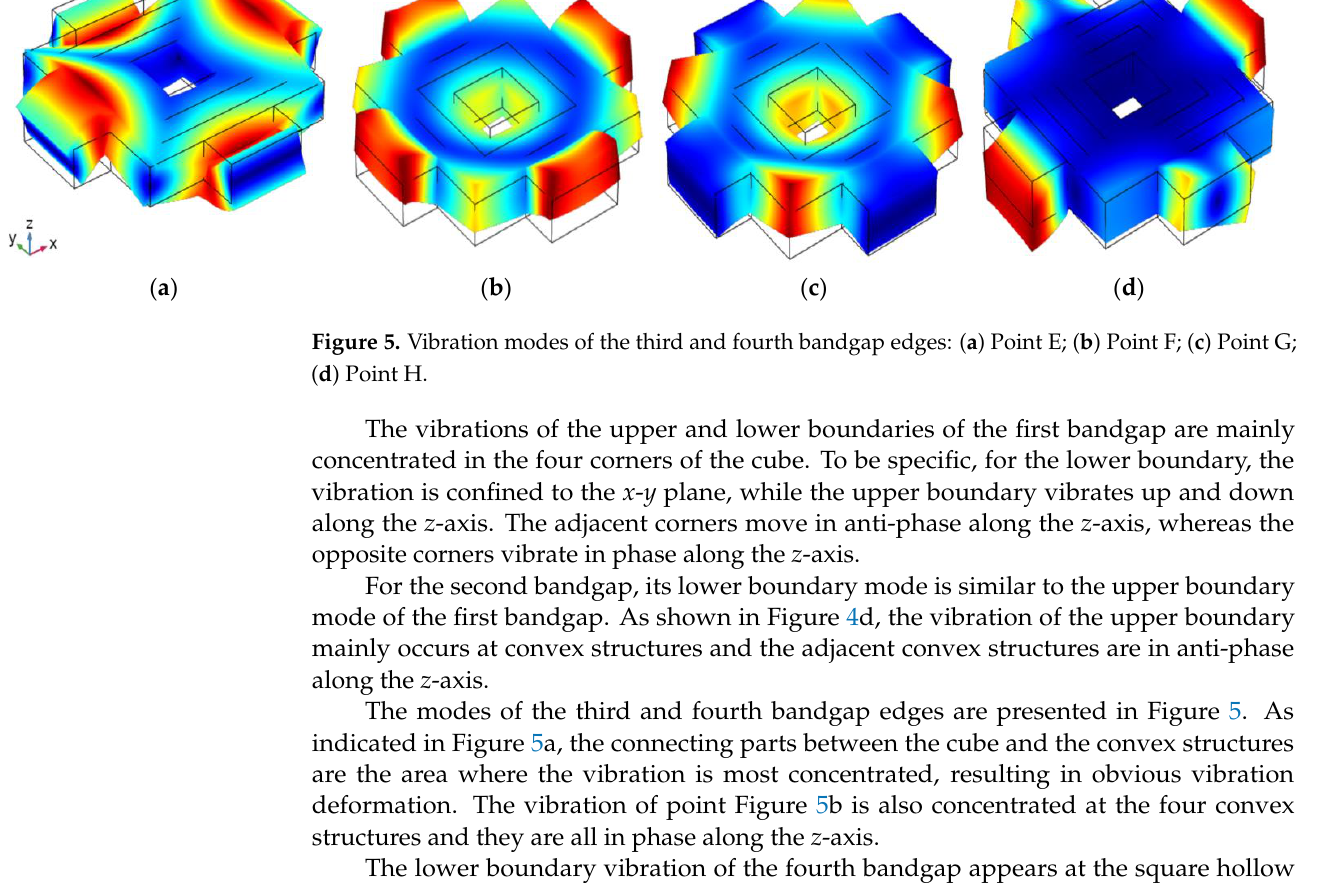
along the z -axis.